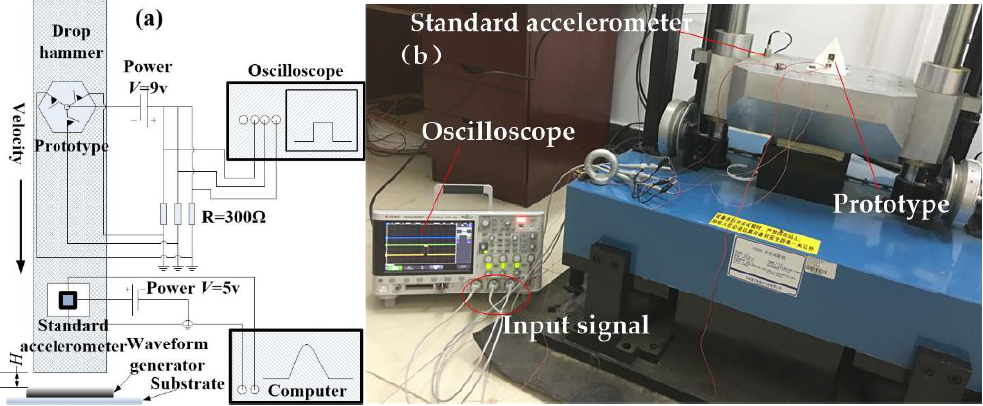
Figure 13. ( a ) The diagram of the dropping hammer system; ( b ) the photo of the test equipment.